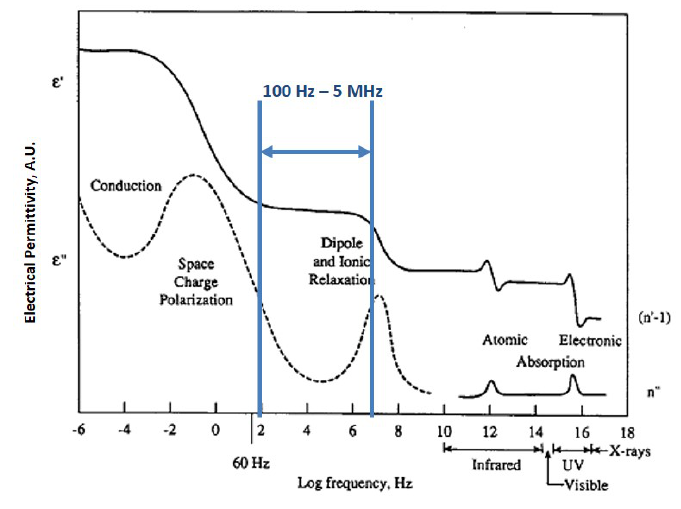
Figure 1. Scheme of ( a ) Conductimetric sensor and ( b ) Dielectric spectroscopy technique.